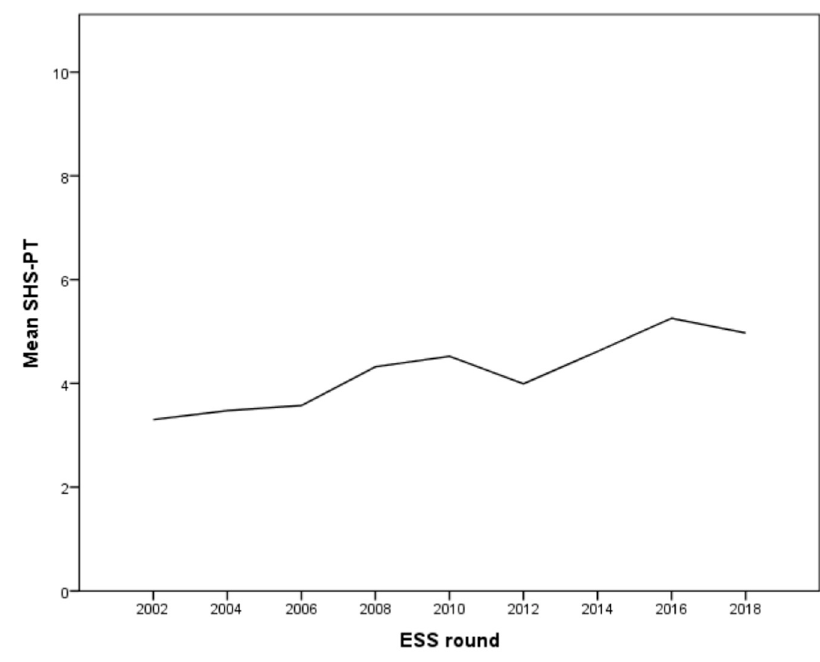
Figure 1. Mean satisfaction level of healthcare services in Portugal, ESS, 2002–2018.